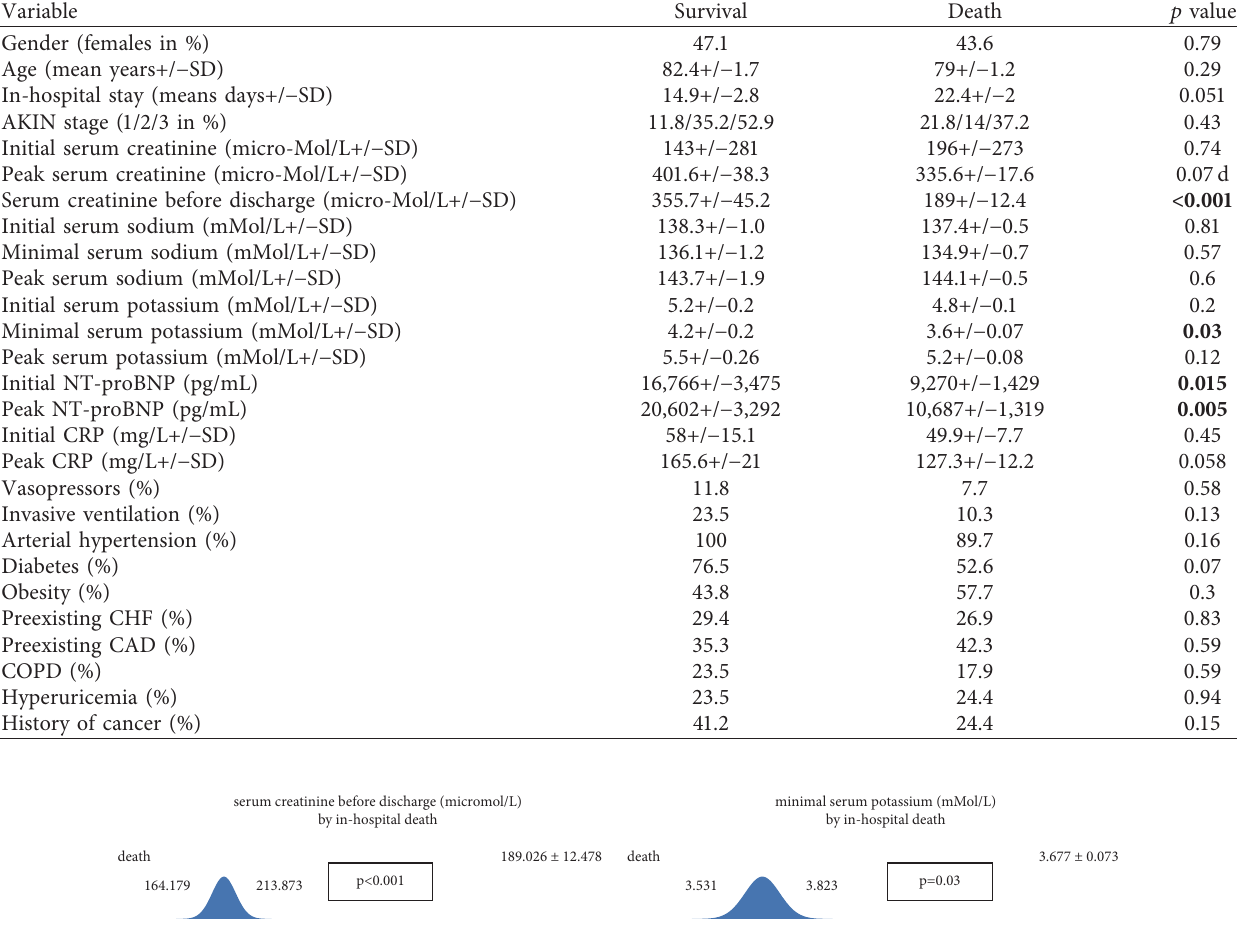
Table 2: Distribution of predefined variables in surviving and nonsurviving patients.